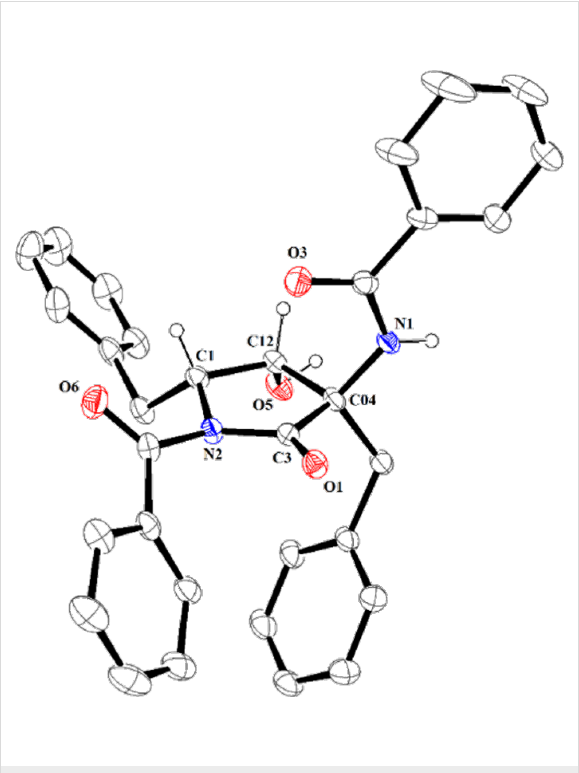
Figure 5: X-ray crystallographic structure of 6 (30% ellipsoids probabil- ity).